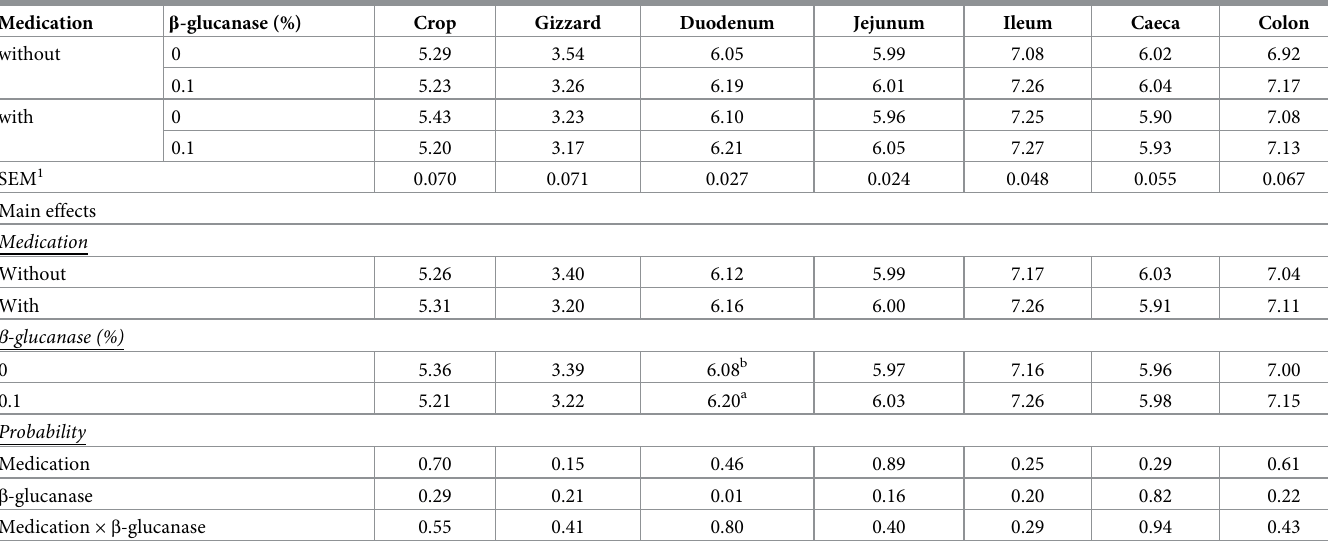
Table 6. Effects of diet medication and β -glucanase on gastro-intestinal pH of broiler chickens at day 28 (Experiment